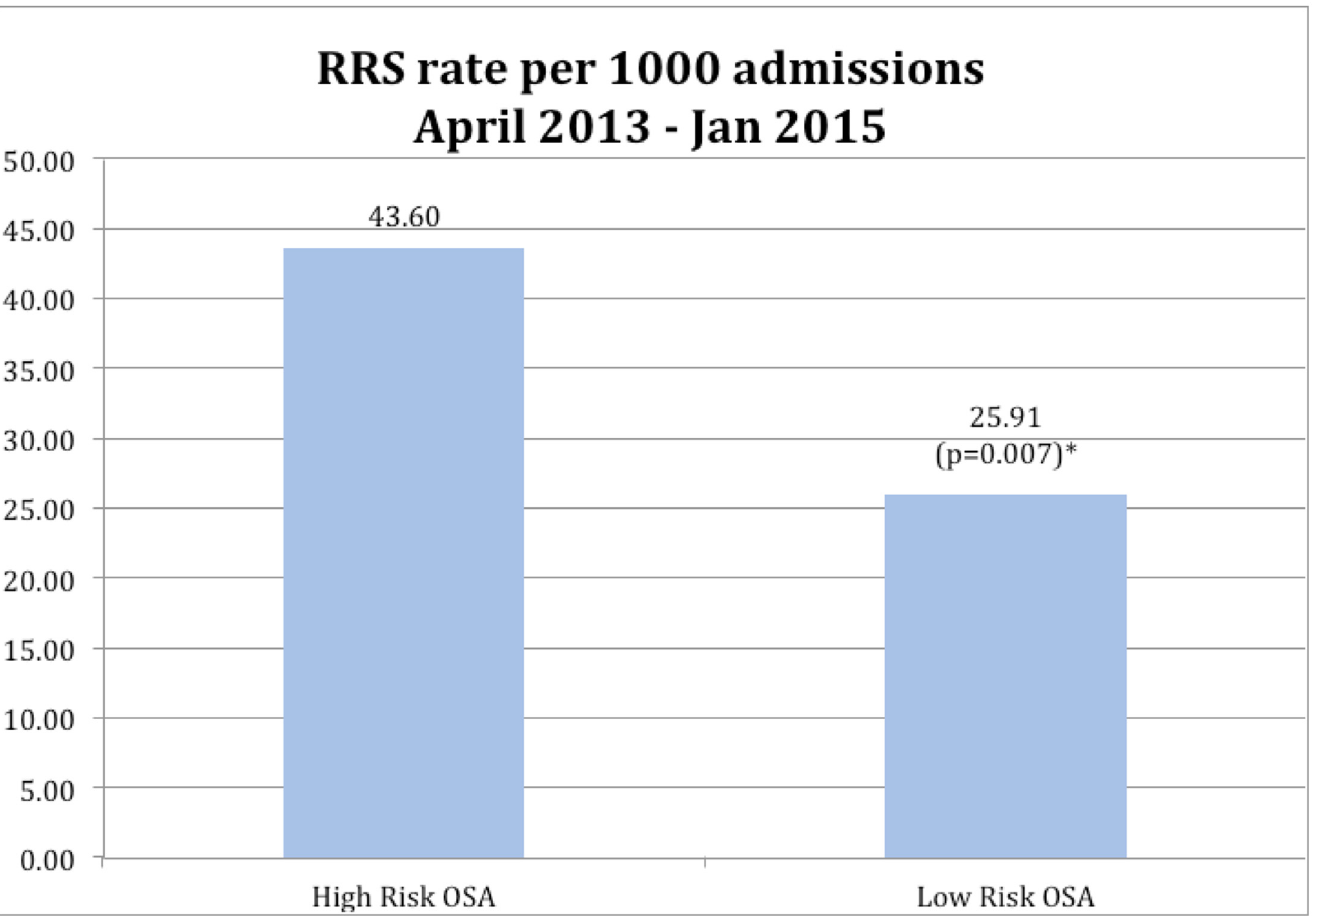
Fig 1. Rapid response system (RRS) events in High Risk OSA patients versus Low Risk OSA patients.